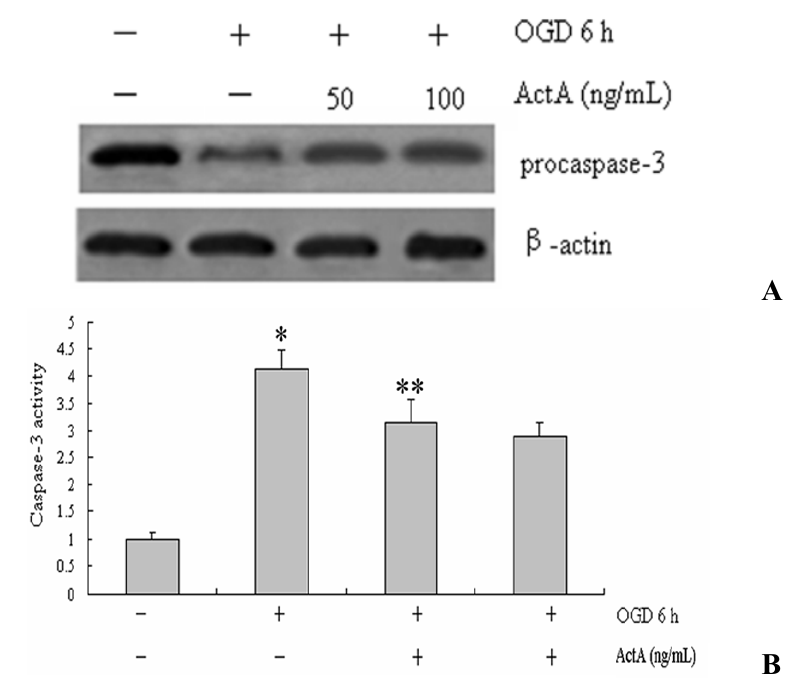
represent from three separate experiments that were performed in